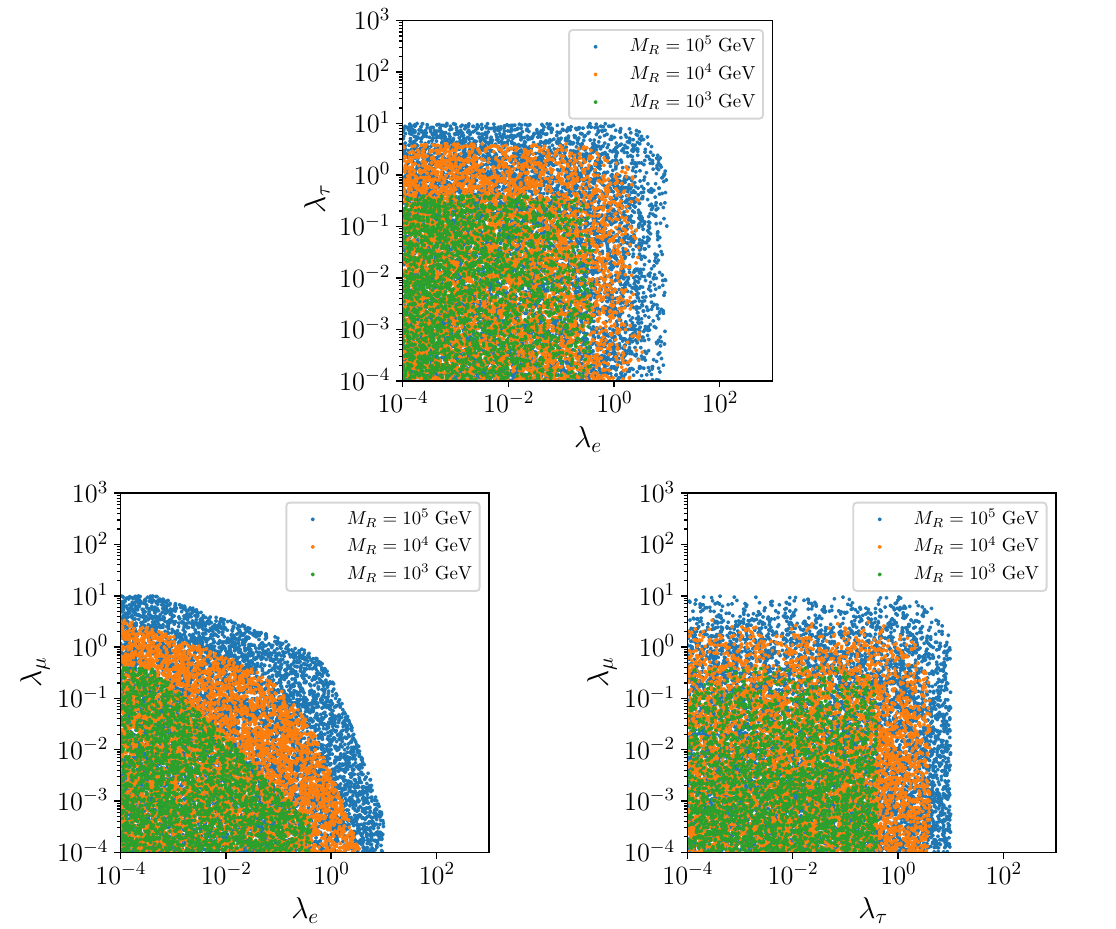
Figure 10. Allowed regions in the different λ i − λ j planes for i, j ∈ { e, µ, τ } and M R = 10 3 GeV, M R = 10 4 GeV, M R = 10 5 GeV (see text for